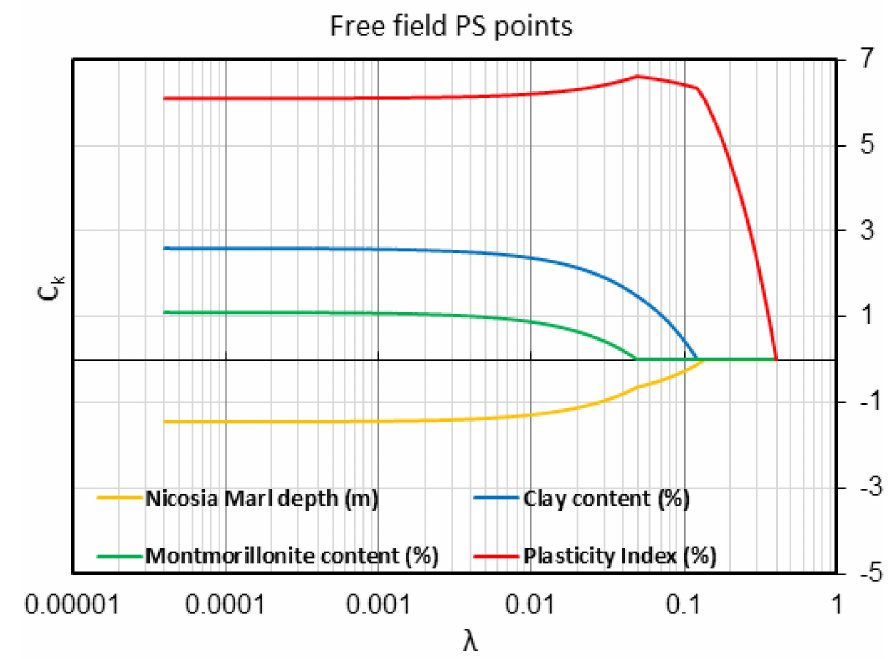
Figure 14. Trace plots of coefficients from Lasso regression for free field PS